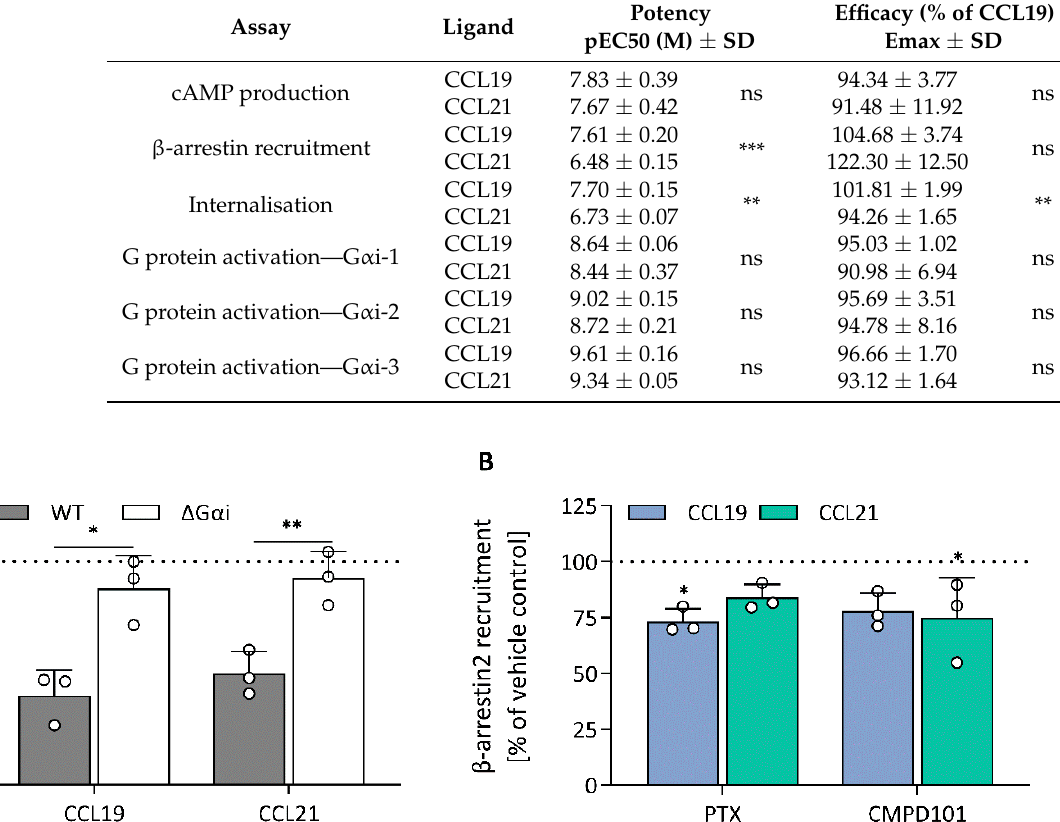
Figure 5. Modulation of cAMP production and β -arrestin2 recruitment. ( A ) The effect of G α i-KO on CCL19- (63 nM) and CCL21- (79 nM) mediated cAMP production was investigated using stable CCR7-expressing HEK293 wild-type and G α i-KO cells transiently transfected with pGloSensor-22F. The effect of the G α i-KO ( ∆ G α i) was analysed against the wild-type cells using an unpaired t-test with Welch’s correction. ( B ) HEK293 cells were transiently transfected with CCR7-LgBiT and β - arrestin2-SmBiT and cells were treated with PTX (50 ng/mL) or CMPD101 (10 µ M) prior to ligand (CCL19 (93 nM) or CCL21 (837 nM)) exposure. Changes in bioluminescence were monitored to assess compound effect on ligand-induced β -arrestin recruitment. A one-way ANOVA followed by a Dunnett multiple comparison was used to assess the effect of PTX and CMPD101 compared to the vehicle control set at 100%. ( A , B ) Data are represented as the mean and SD of three independent experiments with each two or three technical replicates. * and ** represent p < 0.05 and 0.01, respec- tively.